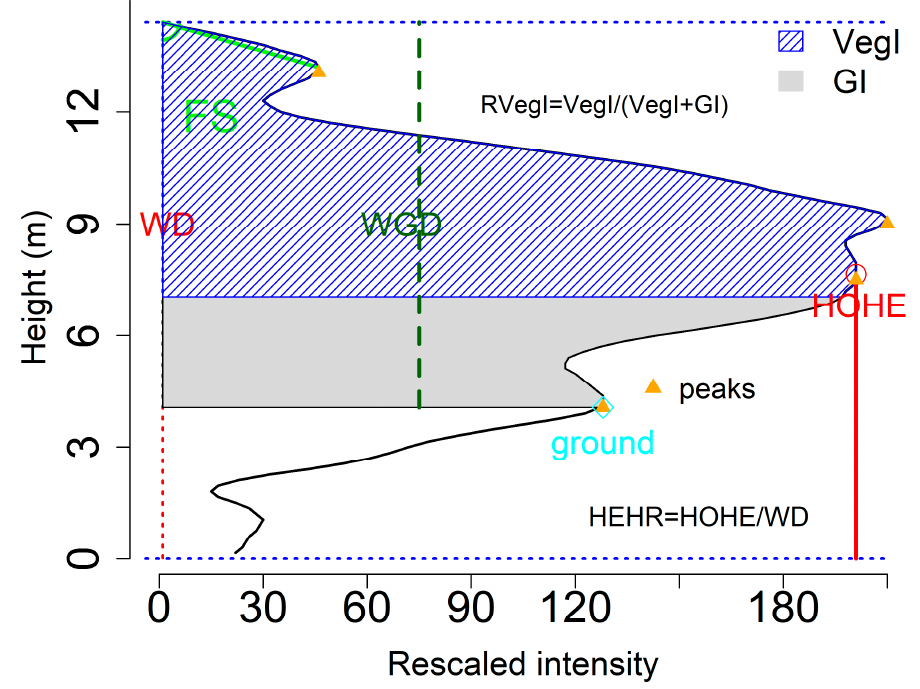
Figure 5. An example of waveform metrics, such as the number of waveform peaks (orange triangle), waveform distance (WD, red dash line), waveform distance from ground (WGD, dark green dash), front slope (FS, green), height of half total energy (HOHE, red line), possible ground location (cyan square), the integral of ground part (GI, gray area), the integral of vegetation part (VegI, blue area) and the ratio of vegetation integral (RVegal) extracting from the waveform.